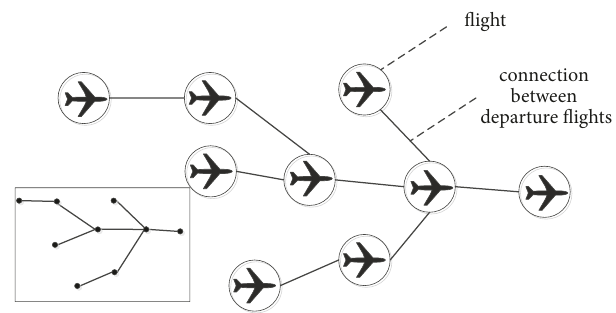
Figure 3: Congestion propagation in departure airport